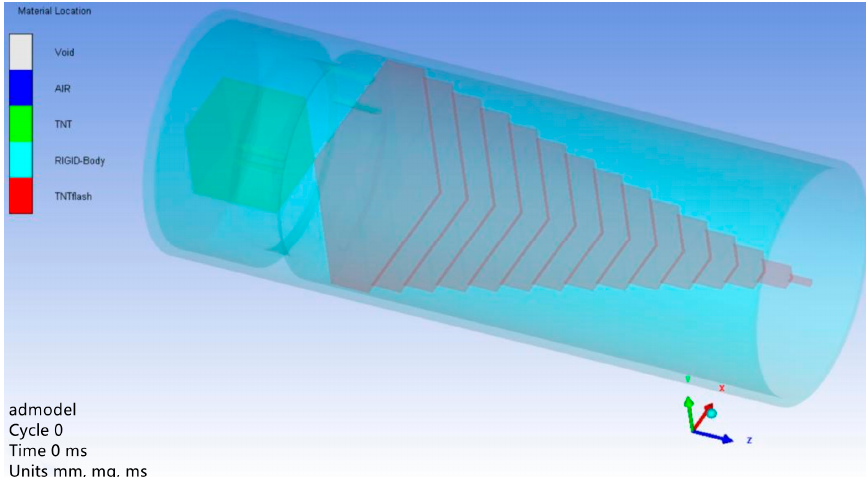
Figure 4. Spatial modeling of each element in the simulation.